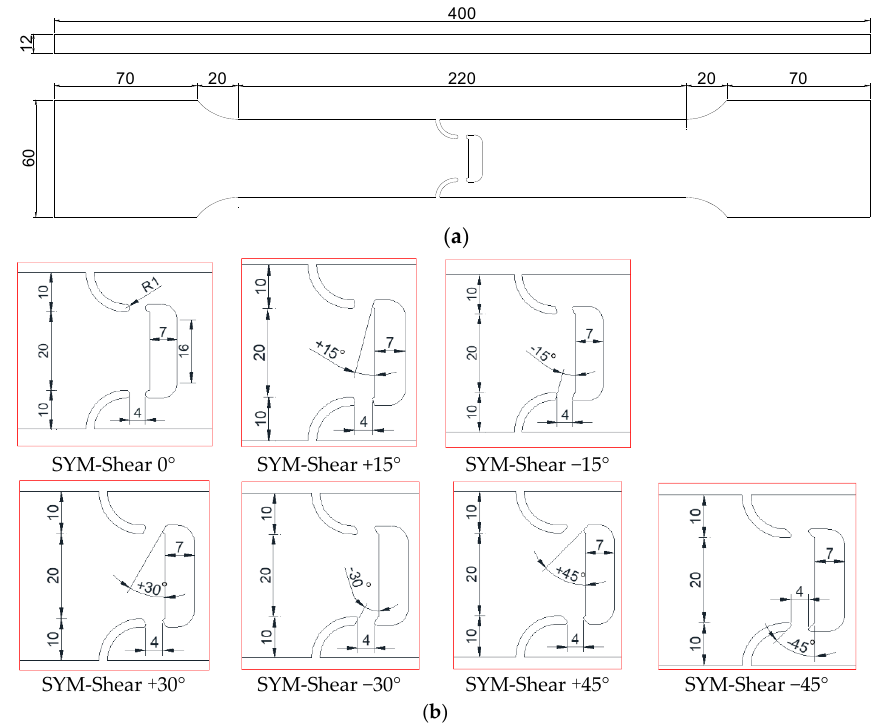
Figure 3. Configuration and dimensions of SYM-Shear specimens: ( a ) Dimensions of the specimen; ( b ) detailed dimensions of the notch (unit: mm).